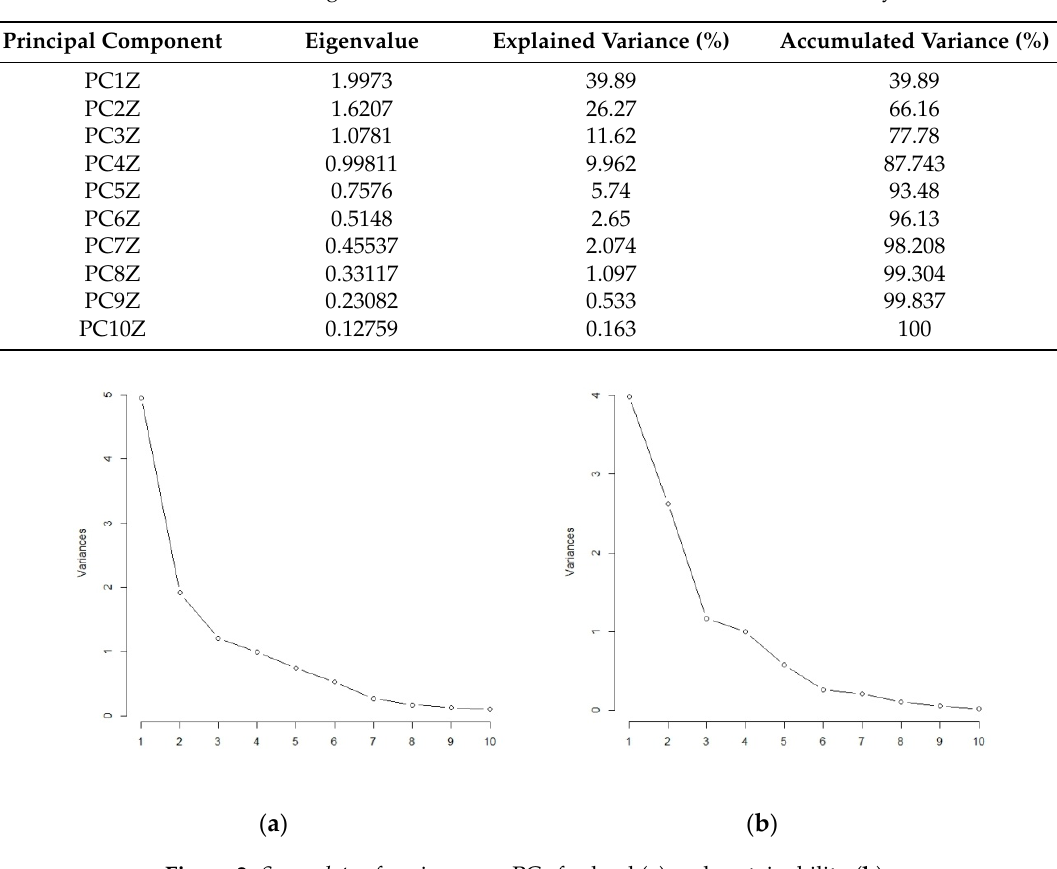
Table 6. Percentage of variance of the ten PCs related to removal efficiency.